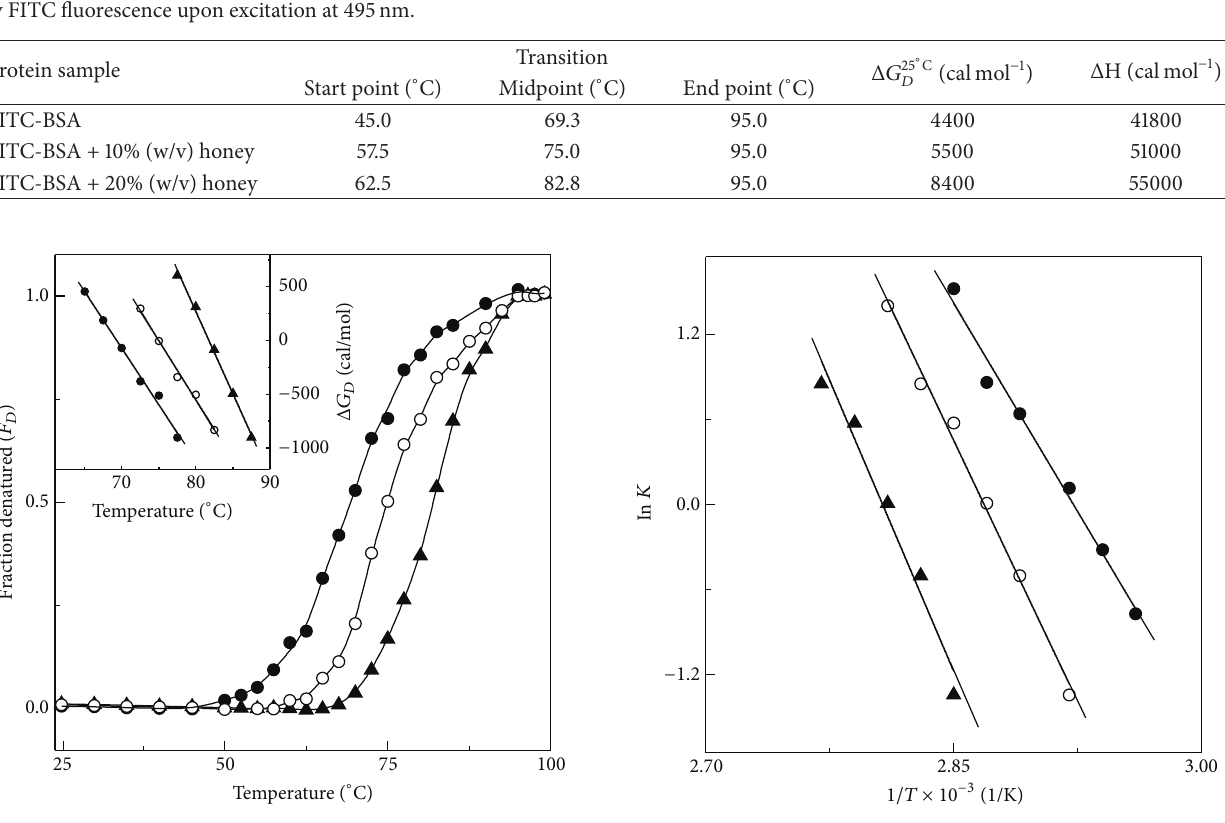
Figure 5: Normalized transition curves of thermal-induced denat- uration of FITC-BSA both in the absence ( e ) and presence of 10% ( I ) and 20% ( 󳵳 ) (w/v) honey as monitored by FITC fluorescence at 522 nm upon excitation at 495 nm. Inset shows dependence of Δ𝐺 𝐷 of FITC-BSA on temperature in the absence ( e ) and presence of 10% ( I ) and 20% ( 󳵳 ) (w/v) honey.